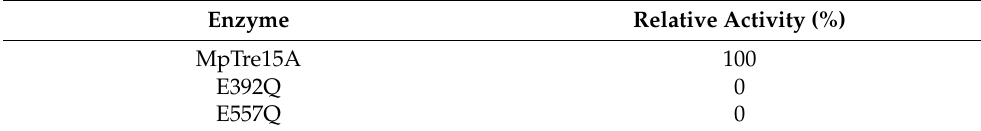
Table 2. Activity analysis of MpTre15A mutants. The specific activity of MpTre15A toward trehalose was 69.4 U/mg protein tested in 100 mM so- dium citrate buffer (pH 5.0).